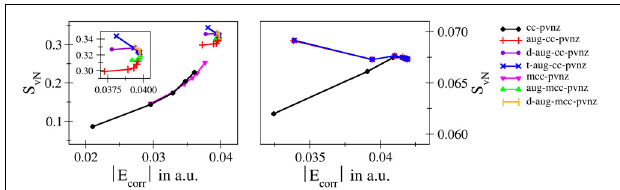
FIGURE 7 | Correlation of S vN against E corr obtained for H − (left) and helium (right) using for different types of basis sets. The varying convergence properties clearly indicate that Collins’ conjecture does not hold in case of small-sized one-electron